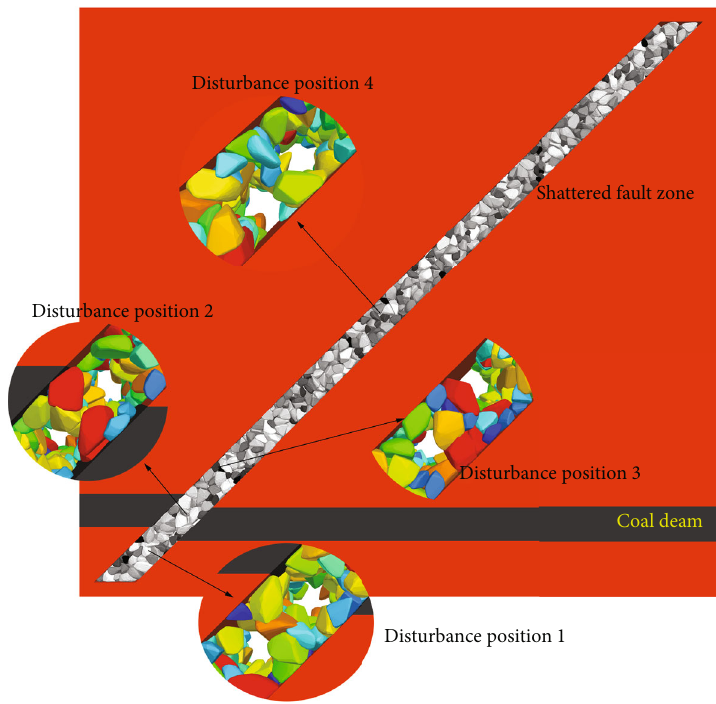
Figure 10: Location and scheme of external disturbance